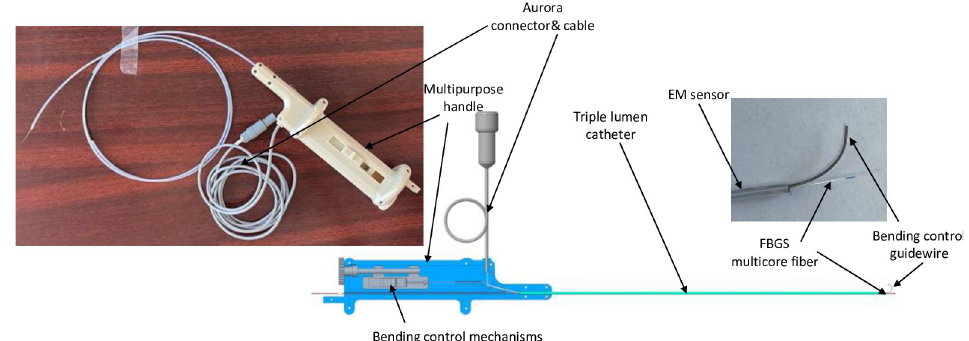
Fig 1. Schematic (a) and physical model (b) of the shape-sensing FBG system. 1- multipurpose handle; 2- three-lumen delivery catheter system; 3- Aurora EM sensor and wire; 4- bending control guidewire, 5 –bending control mechanism; 6 –the FBGS multicore shaper sensing fiber.